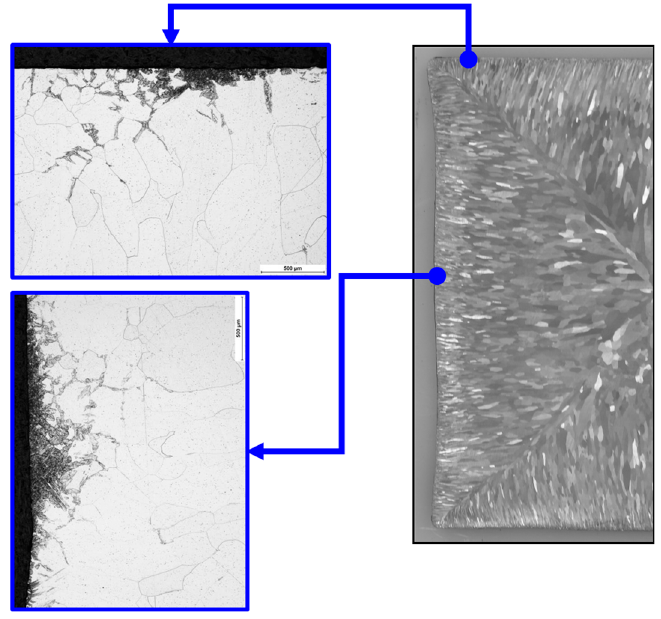
Figure 5. Typical macrostructure of an as-cast billet of ferritic stainless steel.